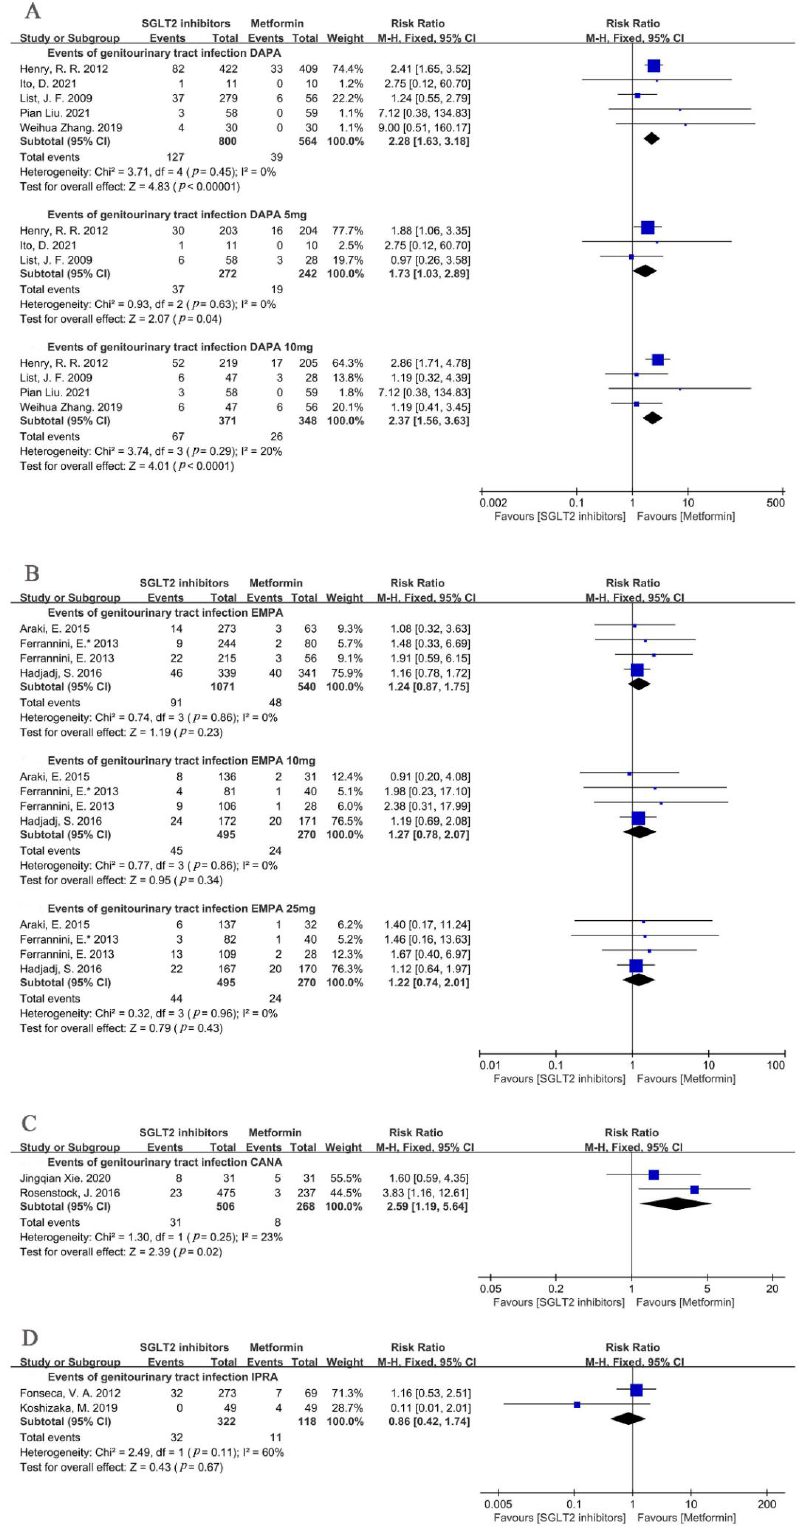
Figure 4. ( A ) Risk of genitourinary tract infections of DAPA and its different doses compared with met- formin [24–28]. ( B ) Risk of genitourinary tract infections of EMPA and its different doses compared with metformin [20–23]. ( C ) Risk of genitourinary tract infections of CANA compared with met- formin [29,30]. ( D ) Risk of genitourinary tract infections of IPRA compared with metformin [31,32]. DAPA = dapagliflozin. EMPA = empagliflozin. CANA = canagliflozin. IPRA =